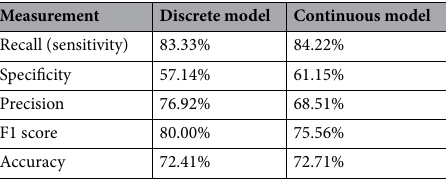
Table 1. The performance metrics of the discrete and continuous Bayesian predictive